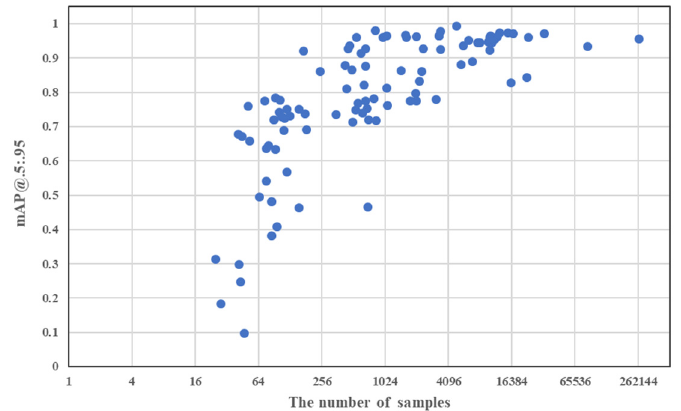
Figure 9. Recognition performance plot for all clusters based the number of samples.